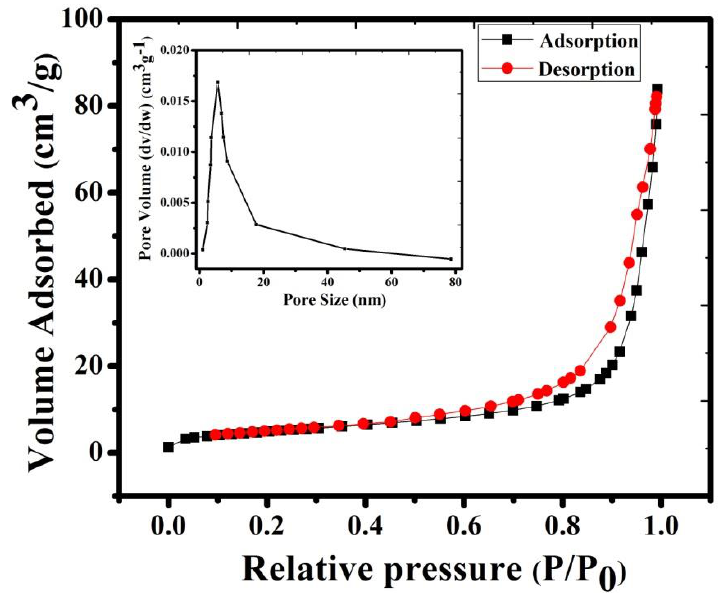
Figure 4. N 2 adsorption–desorption isotherms curve and pore size distribution of NMO calcined at 800 C.